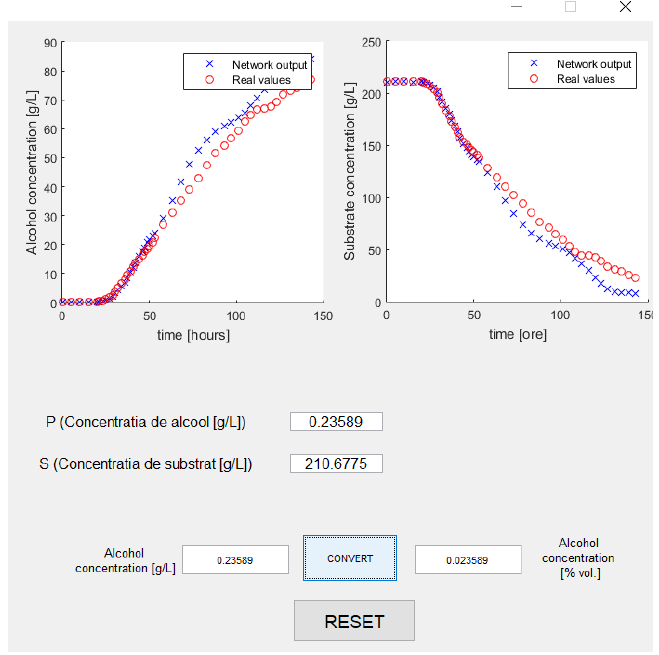
Figure 6. A comparative graphics between the desired output of the network and the real